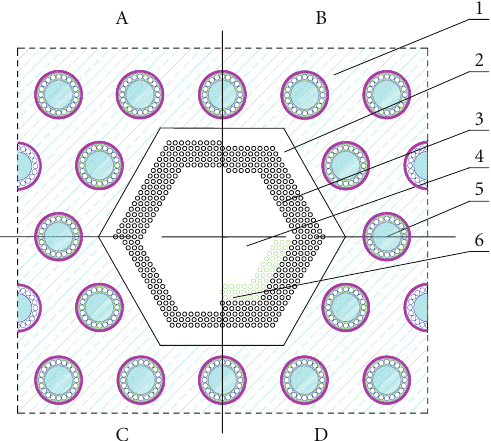
Figure 3: Variants of hard assembly (A) with heavy metal layer thickness, 2cm and 5 rows of fuel rods, (B) with layer thickness, 3cm and 5 rows of fuel rods, (C) with layer thickness, 3cm and 8 rows of fuel rods, (D) with layer thickness, 3 cm and 3 rows of fuel rods. 1: heavy water moderator, 2: heavy metals layer, 3: peripheral fuel rods of the assembly with hard spectrum, 4: gaseous region (middle part of the assembly), 5: fuel assembly with thermal neutron spectrum, and 6: central fuel